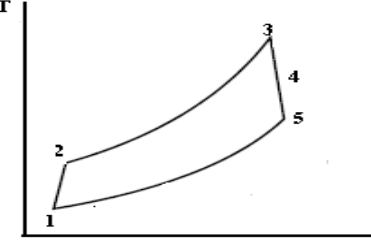
Figure 2. (T-s) diagram of air simple cycle (1, 2, 3, 4 and 5 are the inlet and outlet of each component of ASC in Figure 1a).